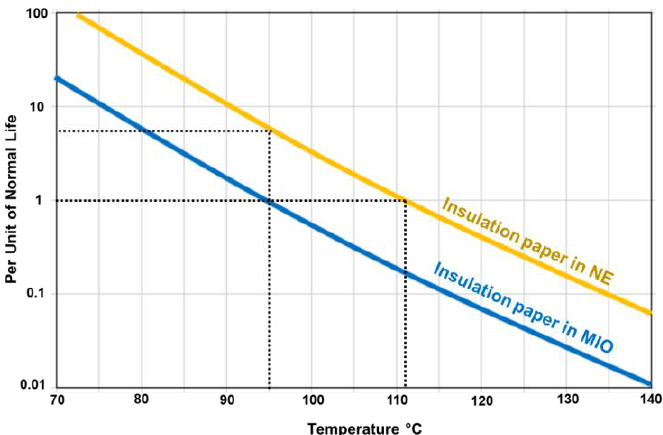
Figure 9. Relative ageing of insulation paper at different temperatures.